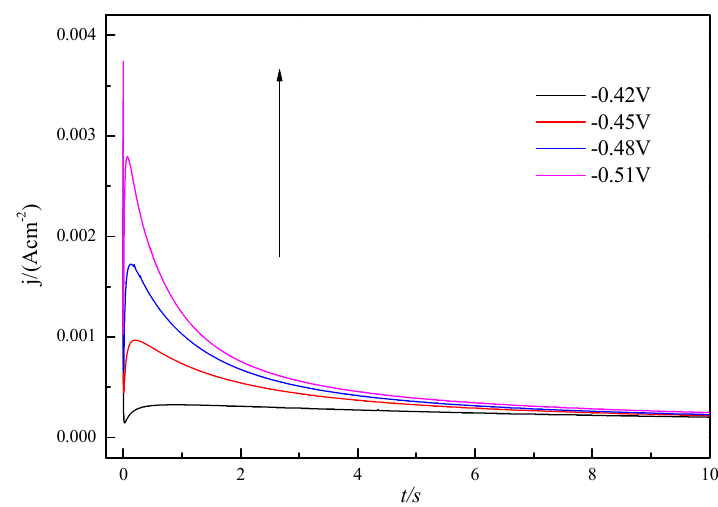
Figure 4. Current–time transients from chronoamperometry in ChCl–urea containing 0.2 M SnCl 2 at 323 K and various potentials (V): − 0.42, − 0.45, − 0.48, − 0.51, − 0.54.